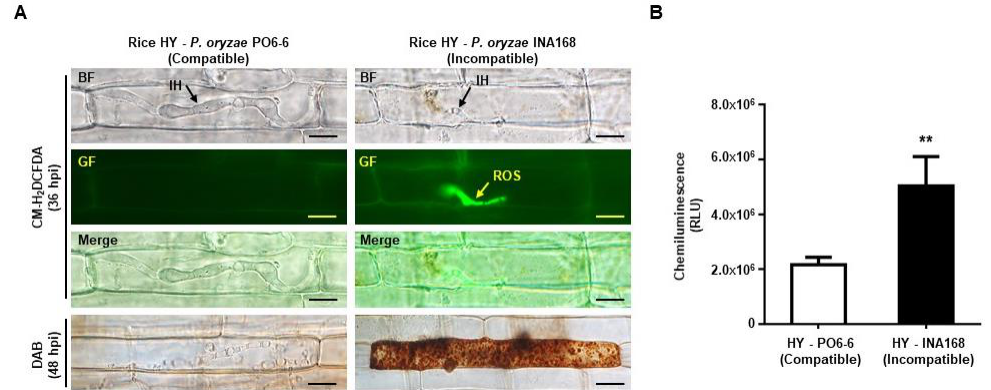
Figure 2. ROS accumulation in compatible and incompatible rice – P. oryzae interactions. ( A ) ROS distribution in HY cells during compatible and incompatible P. oryzae interactions. DAB and CM-H 2 DCFDA staining were performed to detect ROS distribution at 48 hpi and 36 hpi. ( B ) ROS quantification in HY sheath epidermal cells during compatible and incompatible rice– P. oryzae interactions. ROS was quantified by chemiluminescence assay. Values represent means ± SD of total relative luminescent units (RLU). All images were captured using fluorescence microscopy with bright field or green fluorescence filter (488 nm excitation / 505–550 nm emission). BF, bright field; GF, green fluorescence; IH, invasive hyphae. Scale bars = 10 µ m. Asterisks indicate significant differences between compatible and incompatible interactions (Student’s t -test, ** p < 0.01, n = 3).